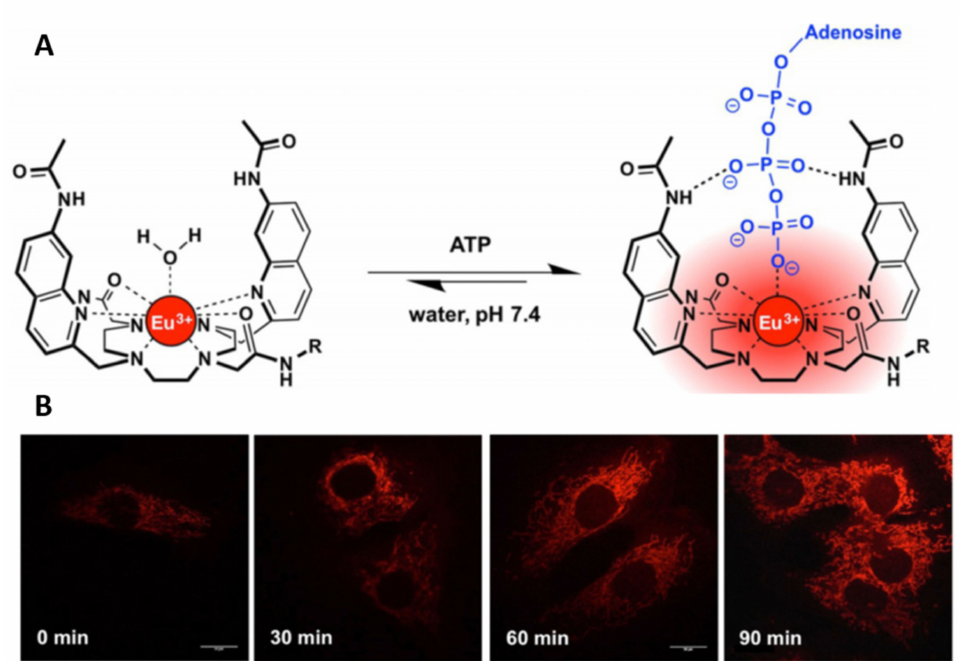
Figure 9. An Eu(III) complex for mitochondrial ATP sensing. ( A ) The proposed binding mechanism between an Eu(III) complex and ATP to elicit a ‘turn on’ luminescent response. ( B ) NIH-3T3 cells treated with staurosporine (10 nM) and stained with an Eu(III) complex (50 µ M, λ exc 355 nm, and λ em 605–720 nm), demonstrating real-time monitoring of ATP levels in mitochondria. Images adapted with permission [268]. Copyright 2018